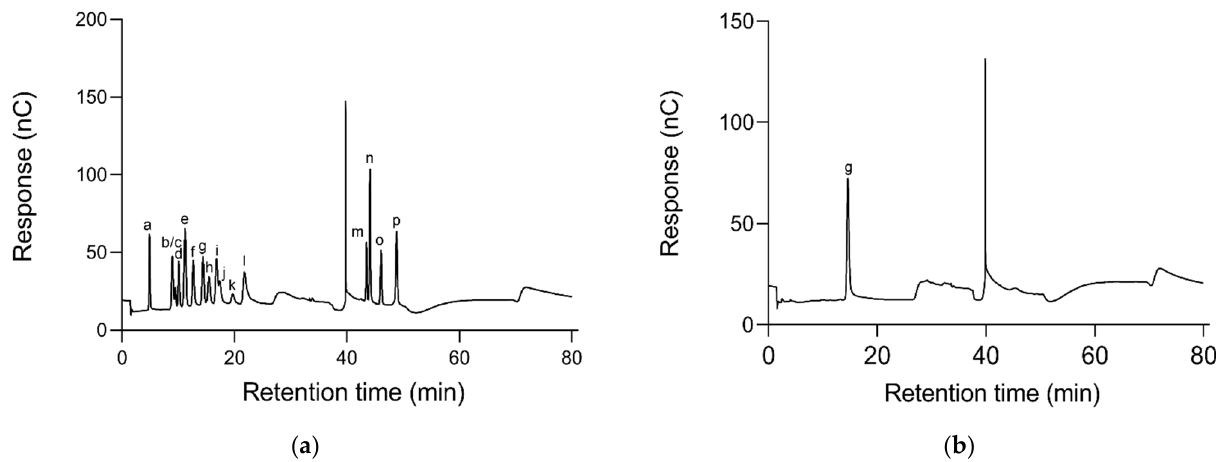
Figure 3. HPIC profiles of standard monosaccharides ( a ) and monosaccharide composition of OFP ( b ). a: Fuc b: GalN c: Rha d: Ara e: GlcN f: Gal g: Glc h: GlcNAc i: Xyl j: Man k: Fru l: Rib m: GalA n: GulA o: GlcA p: ManA.